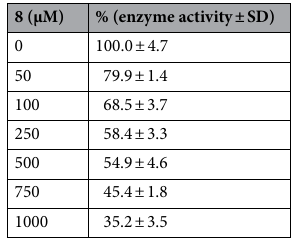
Table 5. Concentration of 8 vs % activity of the